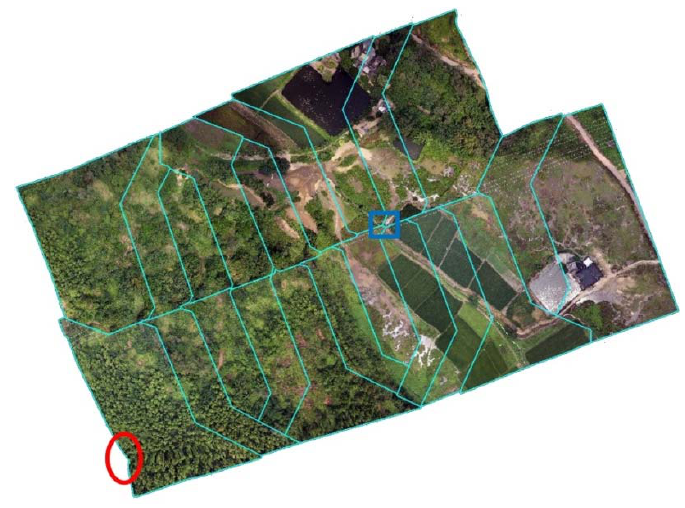
Figure 9. The generated seamline network overlapping the mosaic of Data Set 2 by the presented method.